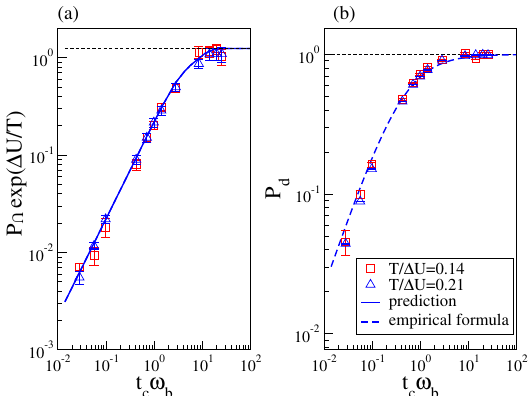
ω Figure 2: Panel a illustrates the t dependence of the probability P ∩ that a flight crosses c b an energy barrier, normalized with the Arrhenius factor. P ∩ is the long time limit of the ratio M ( t ) / N ( t ) , where N ( t ) is the total number of flights until time t , and M ( t ) is the number of barrier crossing flights until time t . The full line represents Eq. 9, the dashed line the asymptotic value for T / ∆ U = 0.21. Panel b shows the fraction of uncorrelated barrier crossing flights, P , described in the text. The full line is an empirical fitting formula based on the d → 0, ∞ limits. Figure from [ 42 ] predicted behavior in the t c